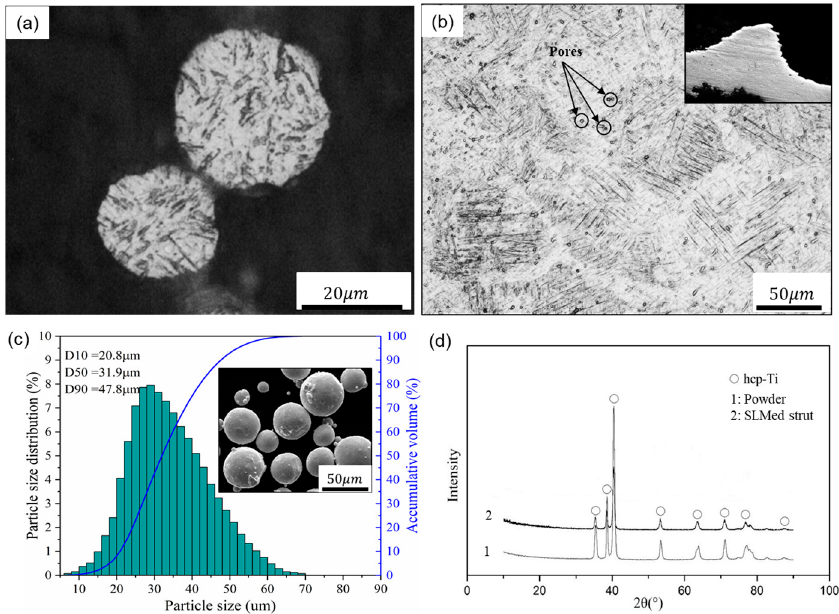
Figure 2. Optical micrographs of ( a ) the powder and ( b ) a strut cross section, ( c ) particle size distribution and SEM image of the Ti-6Al-4V powder, and ( d ) XRD patterns of the powder and SLM produced